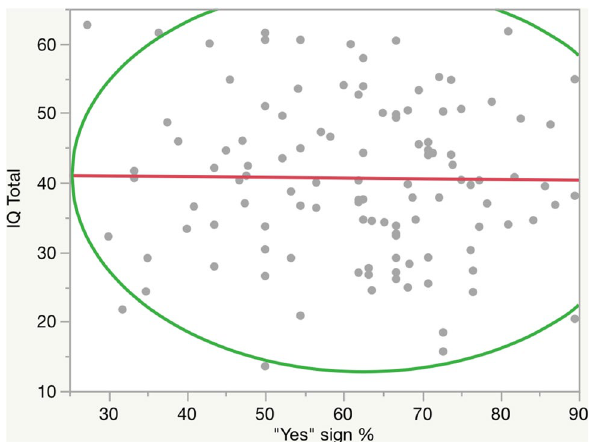
Figure 2. Correlation between the percentage of Jackson’s signs present and IQ scores. Only children for whom cognitive data were available and for whom at least 18 signs were collected (n = 101) were